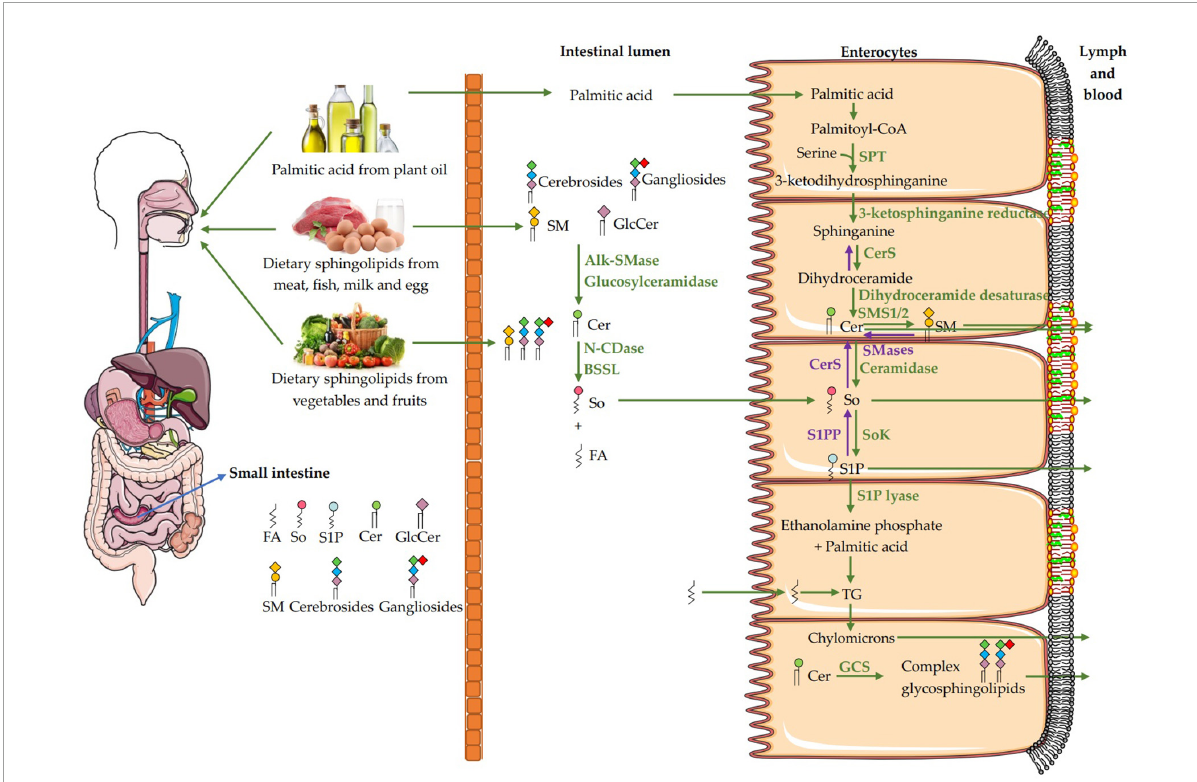
FIGURE2 Pathways for the digestion and absorption of dietary sphingomyelin. The digestion of dietary sphingomyelin (SM) in the small intestinal lumen begins with the decomposition of SM to ceramide by Alk-SMase. Ceramide is further hydrolyzed into sphingosine (So) and fatty acids by N-CDase and BSSL, then the So is absorbed intact into the enterocytes. In the enterocytes, part of So comes from the de novo synthesis of palmitic acid and serine, and part of it comes from intestinal absorption. When the So is absorbed into the enterocytes, only a small amount of free So is transported with chylomicrons to the lymph and blood. Most of the So is catalyzed by sphingosine kinase (SoK) to generate sphingosine-1-phosphate (S1P), and then degraded to ethanolamine phosphate and hexadecenal by S1P lyase, or to a less extend dephosphorylated to new So by S1P phosphatase (S1PP) and then to form ceramides and sphingomyelin. Hexadecenal will be converted to palmitic acid and then esterified into triglycerides (TG), which can be incorporated into chylomicrons for transport. FA, fatty acid; So, sphingosine; S1P, sphingosine-1-phosphate; Cer, ceramide; GlcCer, glucosylceramide; SM, sphingomyelin; SMases, Sphingomyelinase; Alk-SMase, alkaline SMase; N-CDase, neutral ceramidase; BSSL, bile salt-stimulated lipase; SPT, serine palmitoyltransferase; CerS,